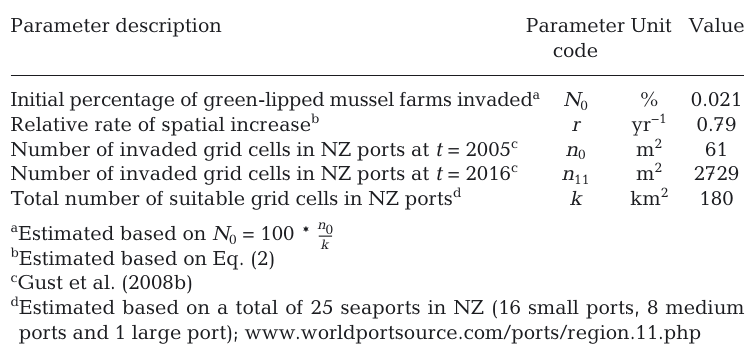
Table 1. Data inputs for the implicit spatio-temporal pest spread model for Styela clava and Sabella spallanzanii in New Zealand (NZ) based on a logistic growth dispersal curve (see Eq.